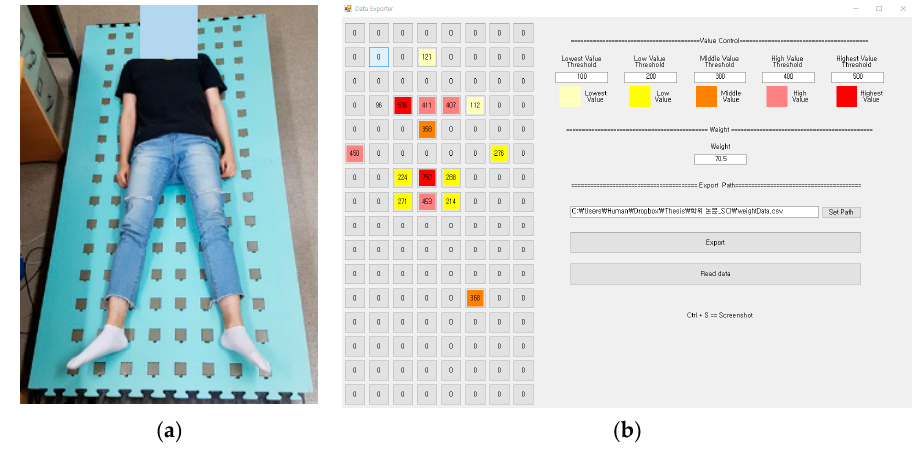
Figure 3. The lying posture in the smart mat ( a ) and the pressure distribution ( b ).